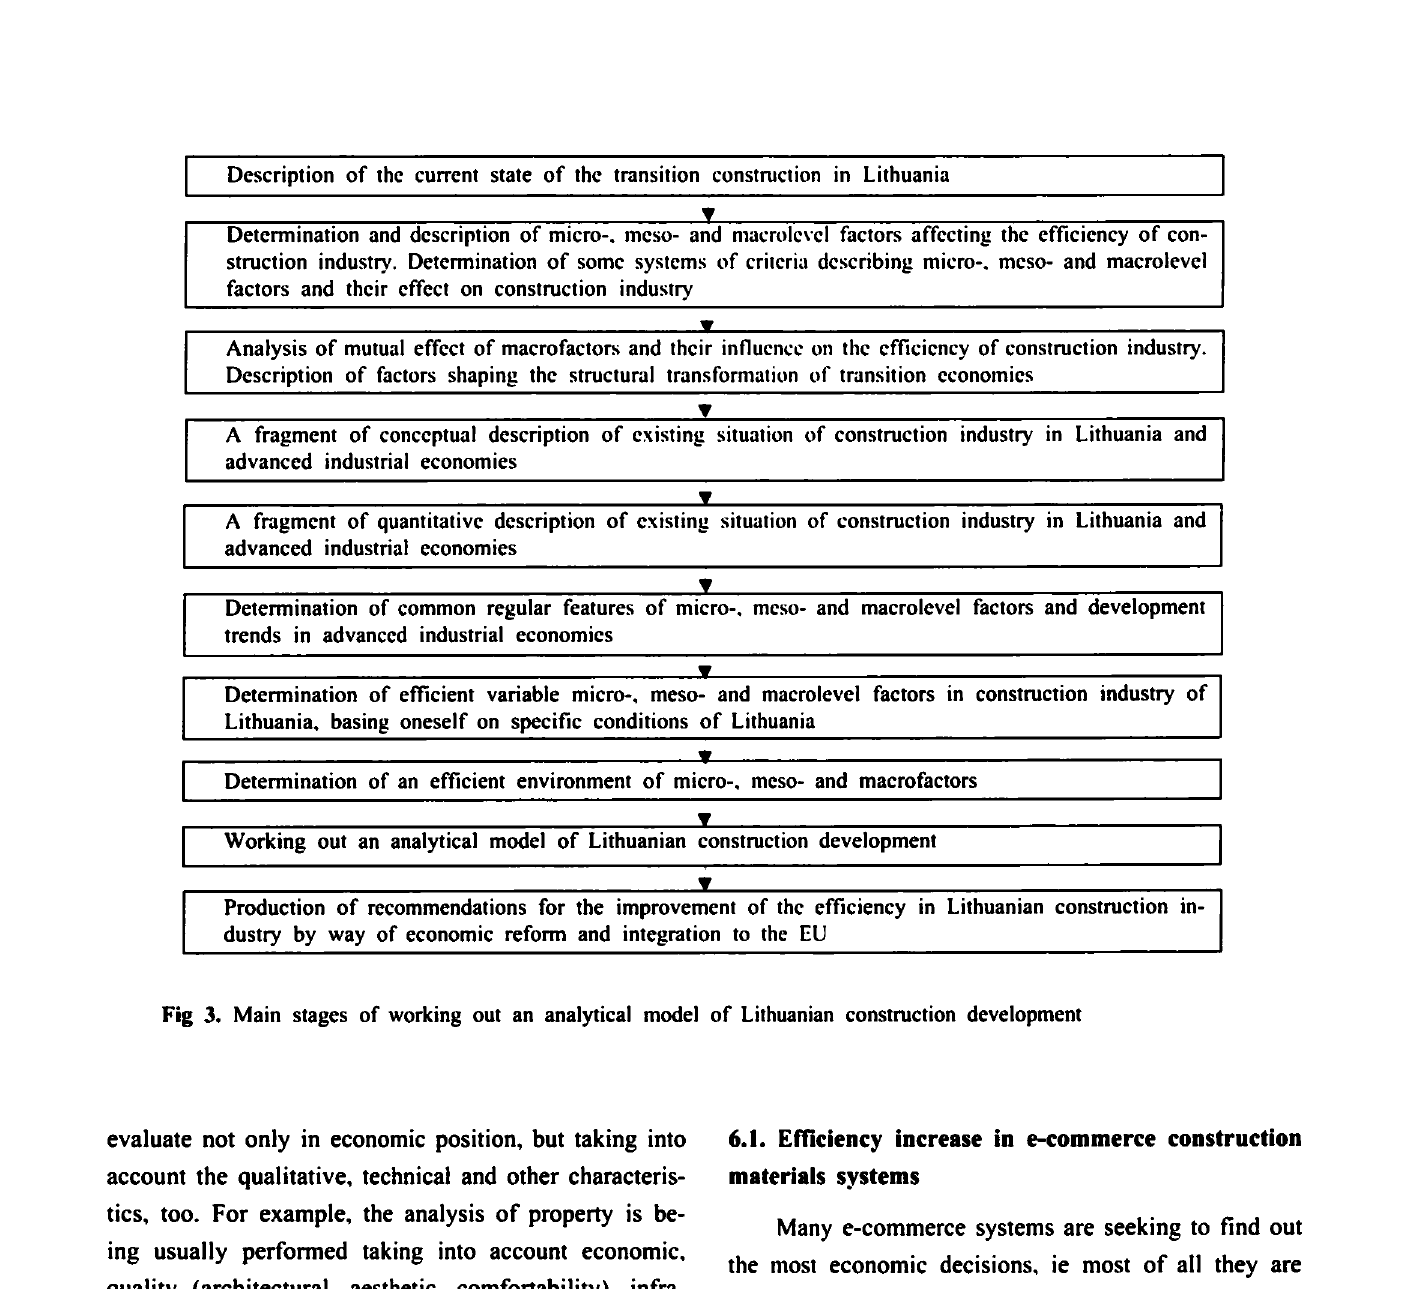
Fig 3. Main stages of working out an analytical model of Lithuanian construction development